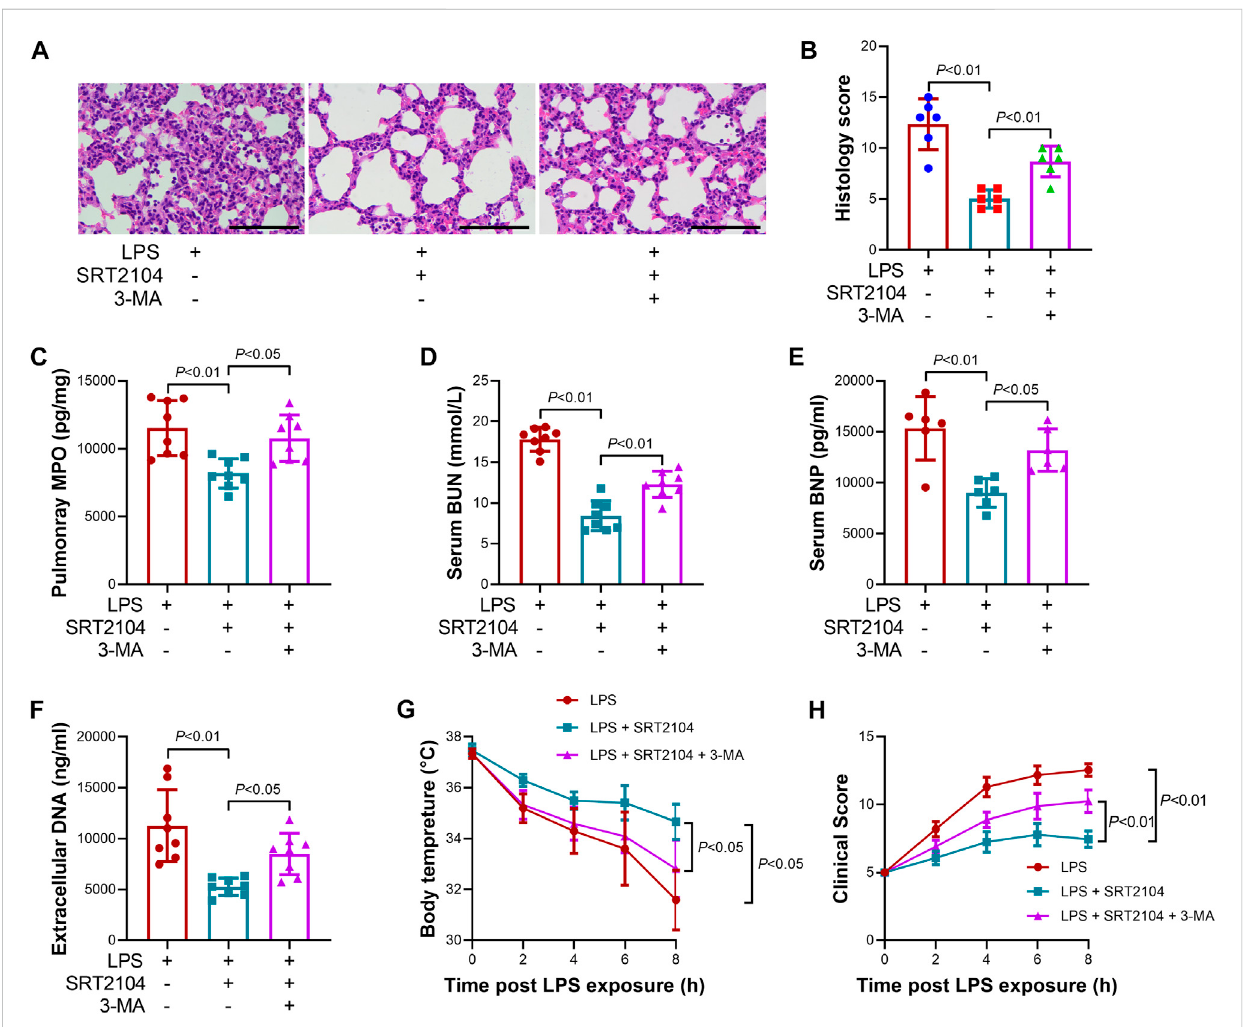
FIGURE 5 Autophagy inhibitor 3-MA reversed the bene fi cial effects of SRT2104 on multiple organ injury. C57BL/6 mice were challenged with LPS to induce systemic in fl ammation,vehicle orSRT2104 (25 mg/kg)was injected intraperitoneally withor without 3-MA (15 mg/kg) co-administration. The mice were sacri fi ced 8 h post LPS exposure, and the lung samples as well as serum samples were collected. (A) HE staining was performed in lung tissues and the representative image of each group were shown (Scale bar: 100 μ m); (B) The histological score was calculated based on the HE-stained sections; n = 6. (C) The level of MPO in lung tissue was determined. (D,E) The serum levels of (D) BUN and (E) BNP were determined; (F) The level of extracellular DNA in serum was determined; (G) The body temperature of the experimental animals was recorded; (H) The clinical score of the experimental animals was calculated; n = 8. Data were expressed as means